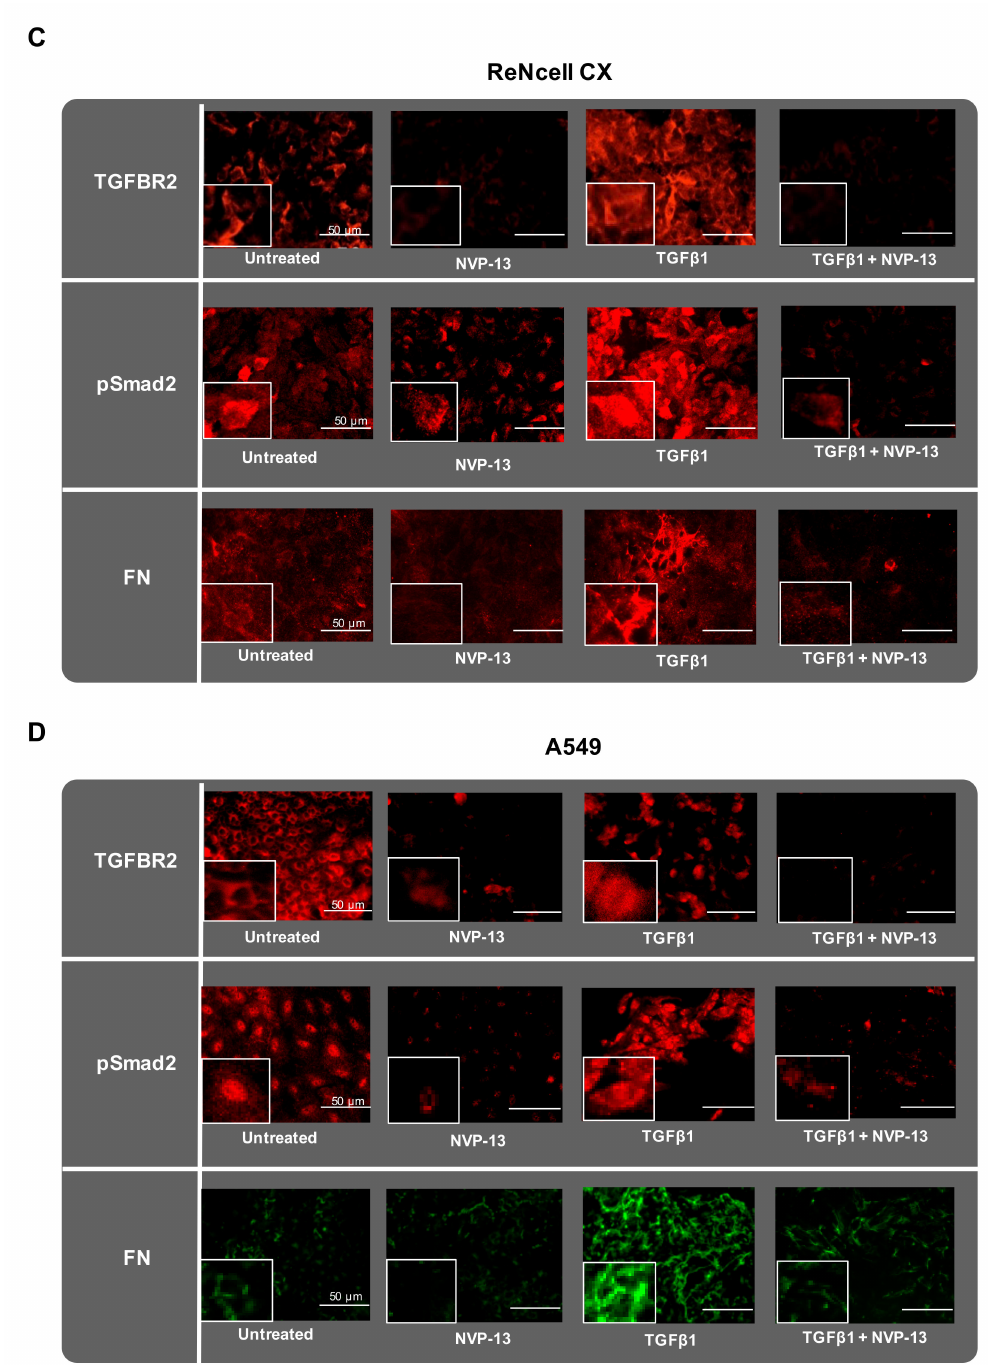
Figure 6. Gymnotic transfer of NVP-13 is e ffi cacious. Heatmaps of mRNA (qRT-PCR) and protein levels (western blot) for TGF β signaling in ReNcell CX ® ( A ) and A549 cells ( B ) are shown. ReNcell CX ® : mRNA and protein levels after 4 d of pre-treatment with TGF β 1 (50 ng / mL) and 8 d gymnotic transfer of NVP-13 (10 µ M) in presence of TGF β 1. A549 cells were pre-treated with TGF β 1 (10 ng / mL) for 2 d followed by 3 d gymnotic transfer of NVP-13 (10 µ M) in presence of TGF β 1. Quantitative RT-qPCR and Western Blotting showed a decrease of all tested proteins after gymnotic transfer of NVP-13 with TGF β 1 co-treatment. mRNA levels were normalized to the housekeeper Gnb2l and